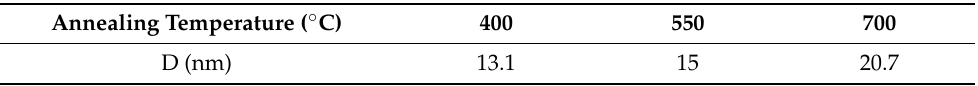
Table 1. Crystallite size as a function of the annealing temperature of ZrO 2